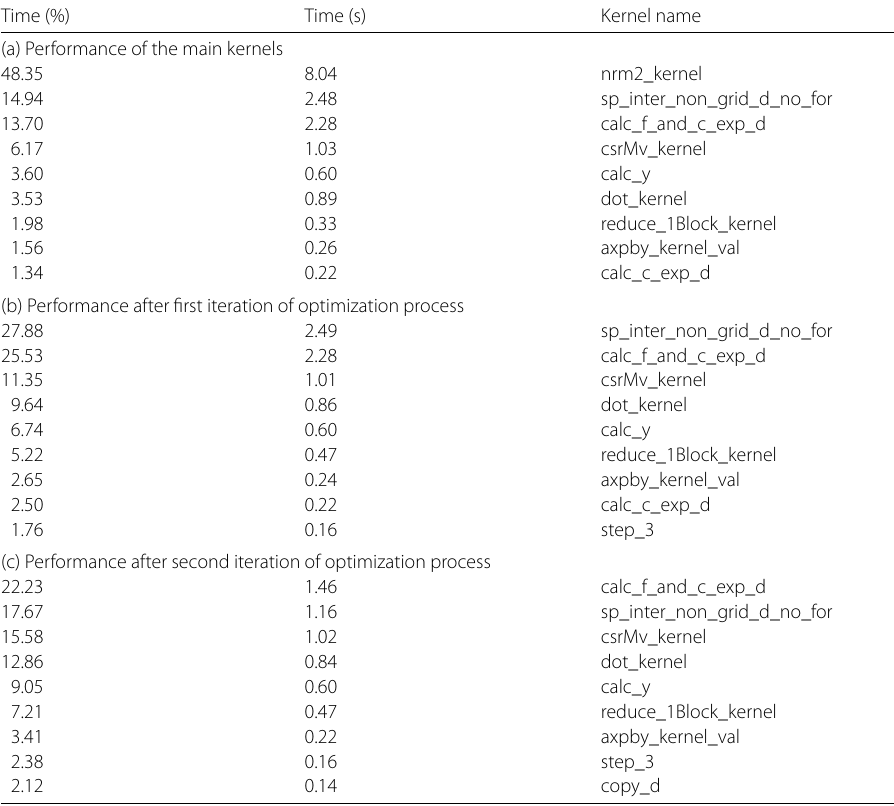
Table 6 Results of iterative optimization process for Example 2 Time (%) Time